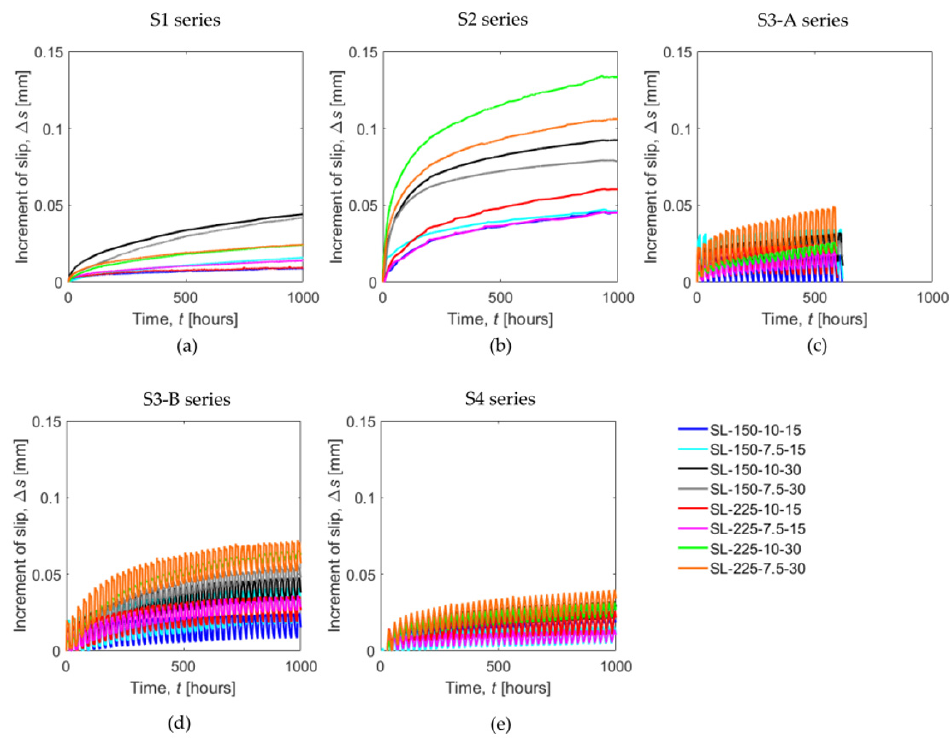
Figure 8. Increment of slip at the loaded end obtained in series ( a ) S1; ( b ) S2; ( c ) S3 ‐ A; ( d ) S3 ‐ B; ( e )